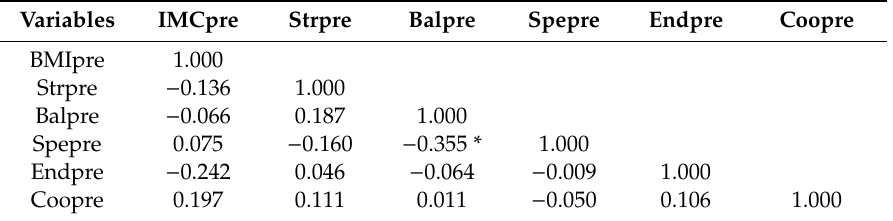
Table 3. Correlations pre-intervention